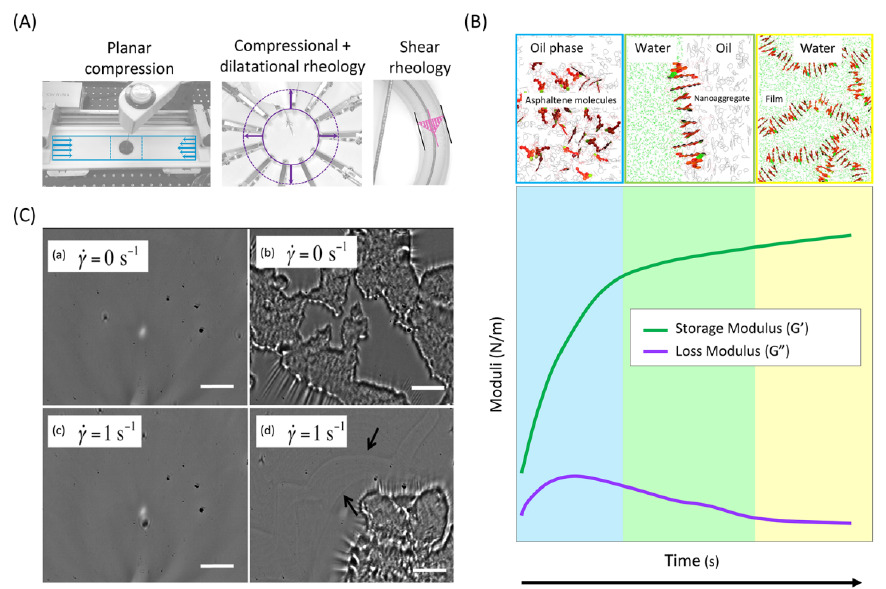
Figure 16. ( A ) Overview of compression, dilatational, and shear rheology techniques and the corre- sponding velocity profiles used to characterize asphaltene–stabilized interfacial films. Reprinted with permission from Ref. [170]. Copyright 2020, copyright American Chemical Society. ( B ) Repre- sentation of the formation of the asphaltene–stabilized interfacial film at the oil–water interface.